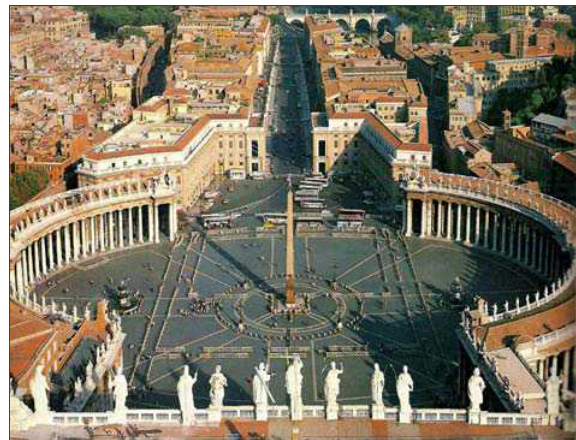
3 pav. Šv. Petro bazilikos renesansinė aikštė (archit. Dažnis Lorencas Berninis) Fig 3. Renaissance square of St. Peter‘s